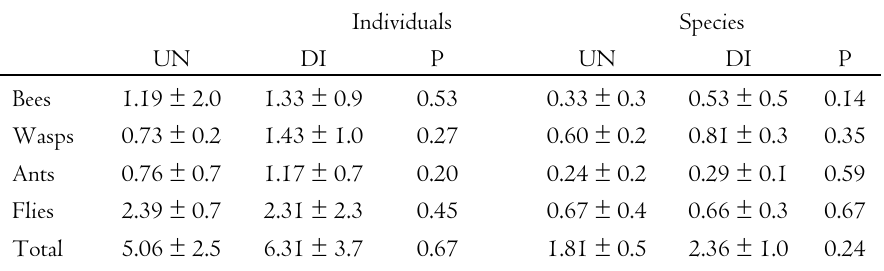
T ABLE 3. Mean (± sd) of combined pollen ratings (see text) for three dorsal, three ventral and six total body sections for abundant species